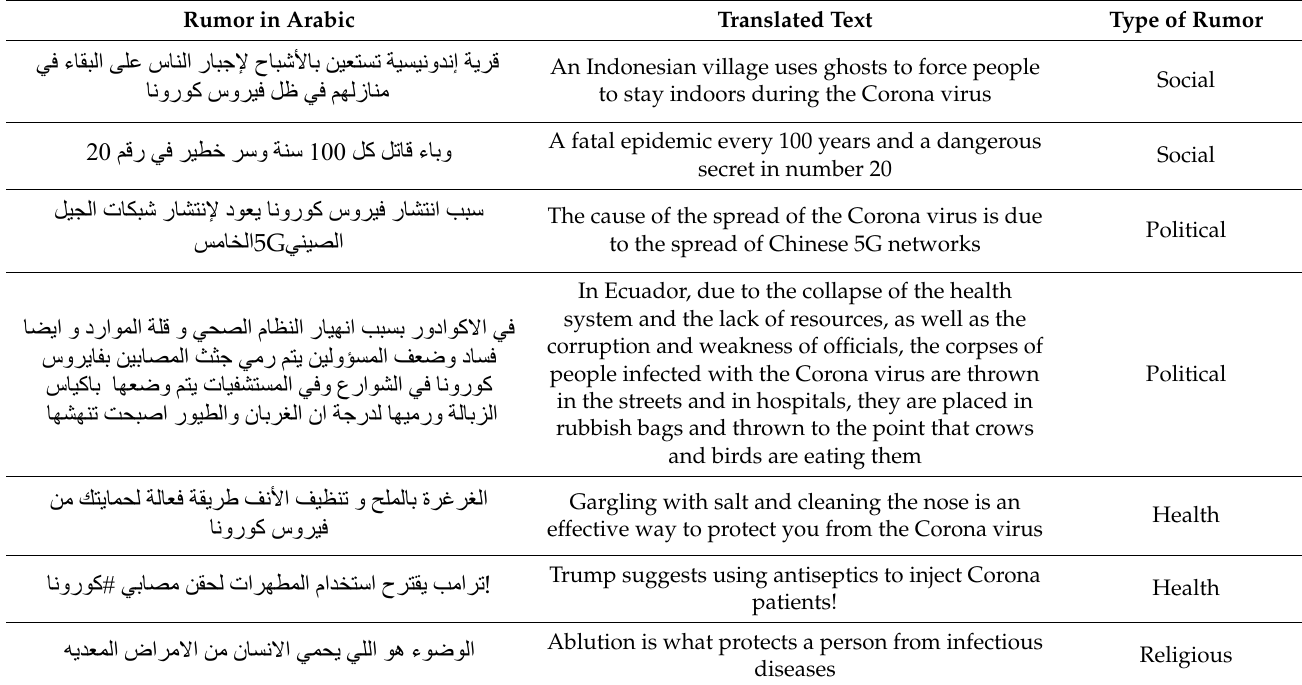
Table 6. Rumor Types and Examples.